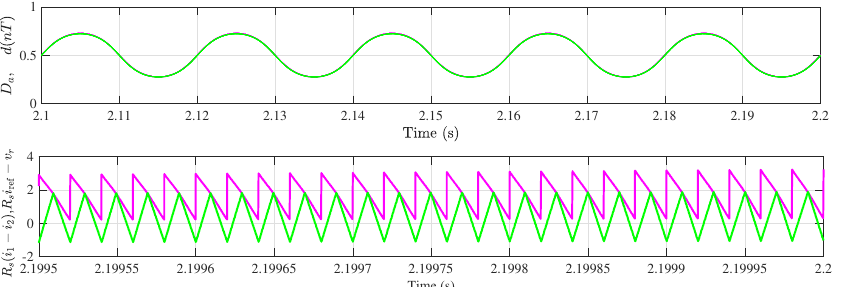
Figure 13. The time varying duty cycle calculated from (12) ( D ( t ) ) obtained from numerical simula- N ) for guaranteeing stability within the complete duty cycle tion ( d ( nT ) , n ∈